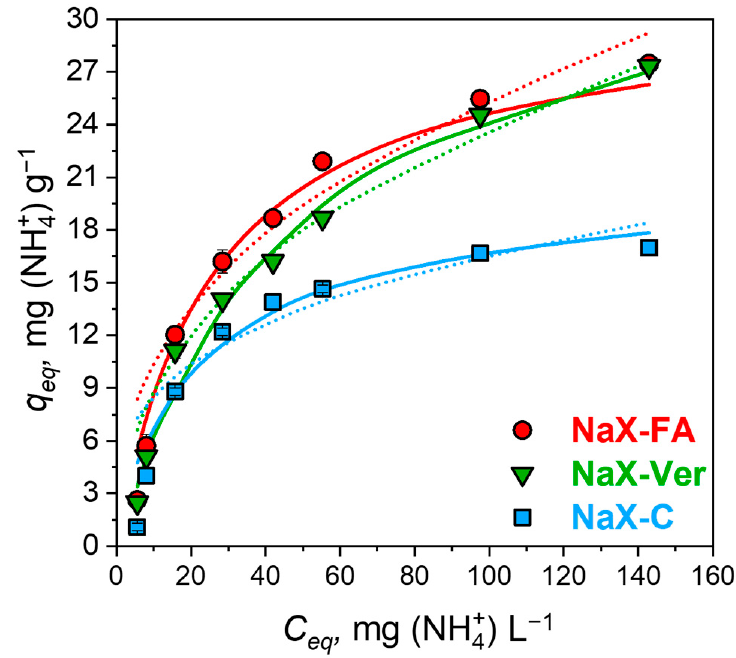
Figure 7. The correlation of adsorption isotherm models: Langmuir (solid line) and Freundlich (dotted line) with experimental data. Error bars indicate the standard deviation of duplicate measurements. Table 6. Comparison of zeolite adsorption capacities toward NH 4+ Table 5. Adsorption isotherm parameters of NH 4+ ion adsorption onto zeolites NaX–FA, NaX–Ver, and NaX–C.